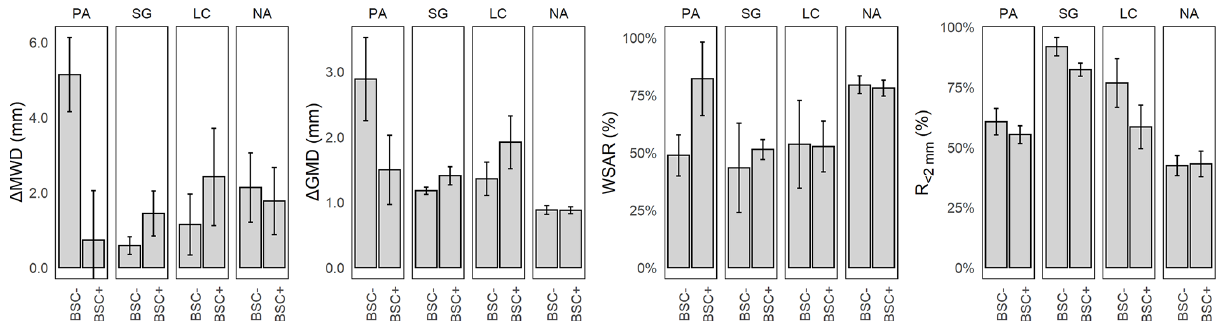
Figure 5. Mean and standard error of aggregate stability indexes for Pan de Azúcar (PA), Santa Gracia (SG), La Campana (LC), and Nahuelbuta (NA) for biocrust (BSC + ) and non-biocrust (BSC − ) treatments. (cid:49) MWD = difference in mean weight diameter, (cid:49) GMD = difference in geometric mean diameter, WSAR = water stability aggregate ratio, R < 2mm = ratio of aggregates less than 2mm. Significant factors and corresponding models for response variables are included in Appendix